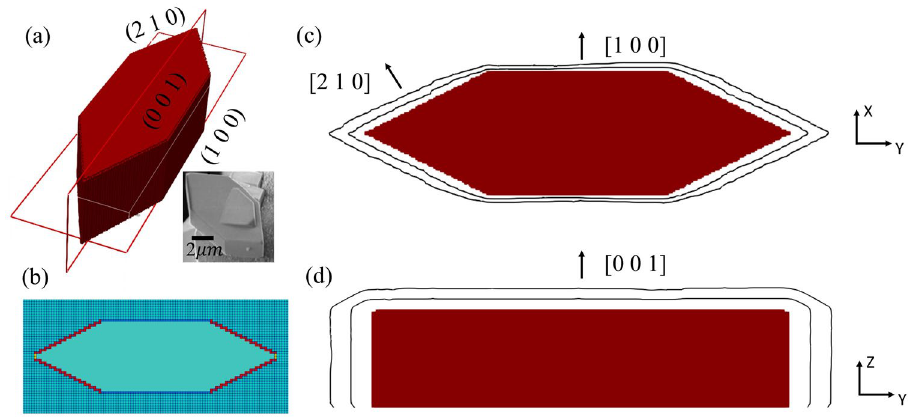
Figure 16. ( a ) Geometry of a barite crystal from experiment. ( b ) Schematics of reaction rate constants assigned to the surfaces of the crystal with different surface norm. ( c ) Contour lines of crystal surface at 3 h and 6 h on the XY plate. ( d ) Contour lines of crystal surface at 3 h and 6 h on the YZ